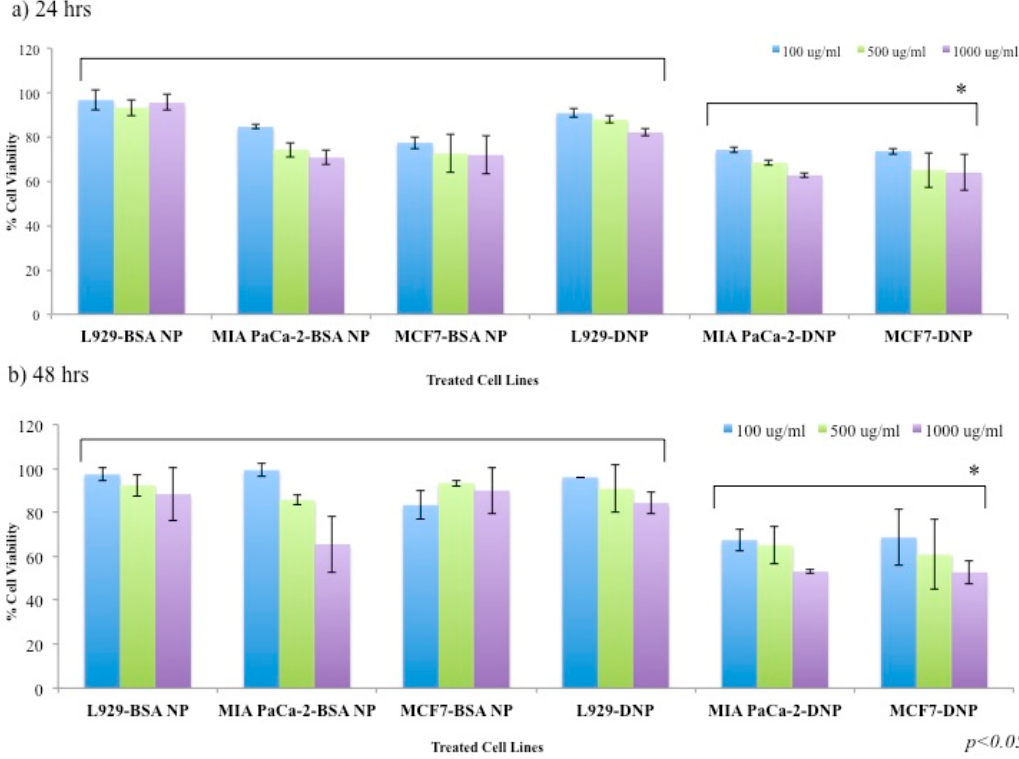
Figure 9. ( a , b ) Percent cell viability of MIA PaCa-2 and MCF-7 (cancer) cell lines treated with DNPs in comparison to treatment of L929 as control. Figure shows comparative account for cell lines treated with blank BSA NPs and DNPs. It also shows the cytotoxic and biocompatible effect exhibited by DNPs and native BSA NPs, respectively, in both concentration and a time-dependent manner. We observed that blank BSA NPs and DNPs are biocompatible towards L929 in a concentration- dependent manner compared to that of MIA PaCa-2 and MCF-7 with * p < 0.05. The comparison was drawn between groups (between test and control groups as well as between two time points) for calculation of statistical significance.